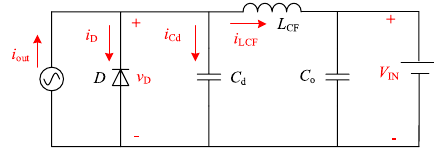
Fig. 5 Equivalent circuit of the “off” module